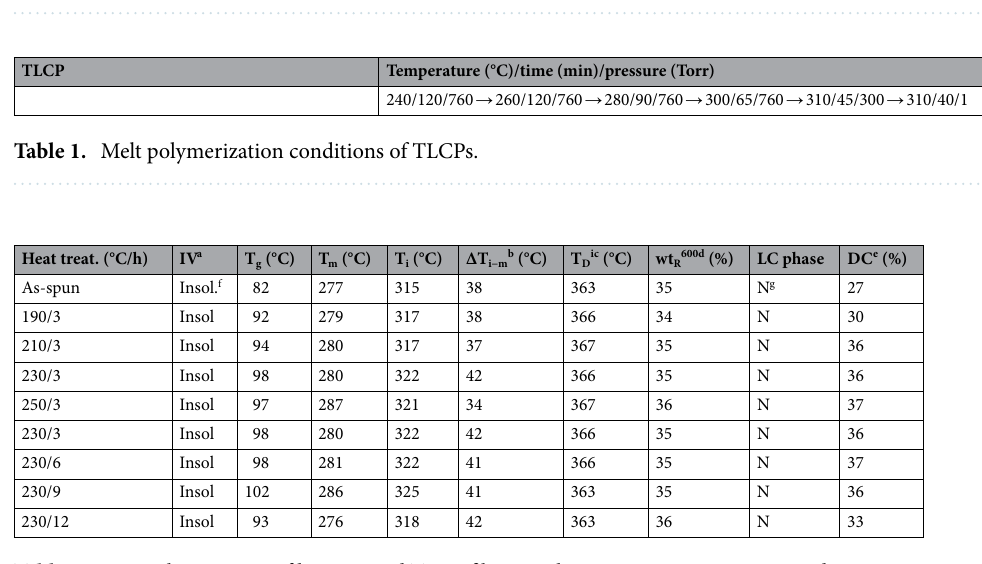
Table 2. General properties of heat-treated TLCP fibers. a Inherent viscosity was measured at a concentration of 0.1 g/dL solution in phenol/ p -chlorophenol/TCE = 25/40/35 (w/w/w) at 25 °C. b Temperature ranges of the liquid crystalline mesophase. c At a 2% initial weight-loss temperature. d Weight percent of the residue at 600 °C. e Degree of crystallinity. f Insoluble. g Nematic.